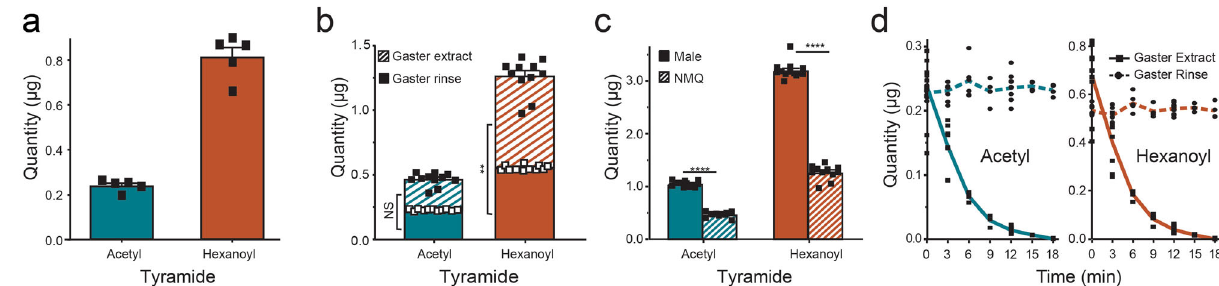
Fig. 2 Tyramide transfer from male to winged females during mating and tyramide loss. a Acetyl- and hexanoyl-tyramides were recovered from Newly Mated Queen (NMQ) gaster tip rinses and quanti fi ed ( N = 5). b In a separate experiment, tyramide quantities were determined from NMQ gaster tip rinses and gaster extracts from the same NMQs (paired T-test, Wilcoxon match-pairs signed ranks test, n = 11). c The amount of tyramides available from the male ( n = 13) are compared with the total amount recovered from NMQs ( n = 11, t = 0) using a T-test (acetyl-) and Mann − Whitney test (hexanoyl-) to account for non-gaussian data. d The loss of tyramides transferred to winged females during mating from gaster rinses and gaster extracts was measured over time, from 0 (time at collection) to 18 min at 3 min intervals. Replicates for the 7 time periods were: 11, 8, 6, 4, 10, 4, 4, respectively. All replicate values represent biologically independent samples. Tyramides from gaster rinses did not change with time; however, tyramides from gaster extracts were undetectable or in trace amounts by 18 min. In all plots, acetyl tyramide values are represented by teal bar/line, hexanoyl tyramide by orange bar/line, points represent individual NMQs or Males. ** p < 0.01; **** p < 0.0001. Error bars =